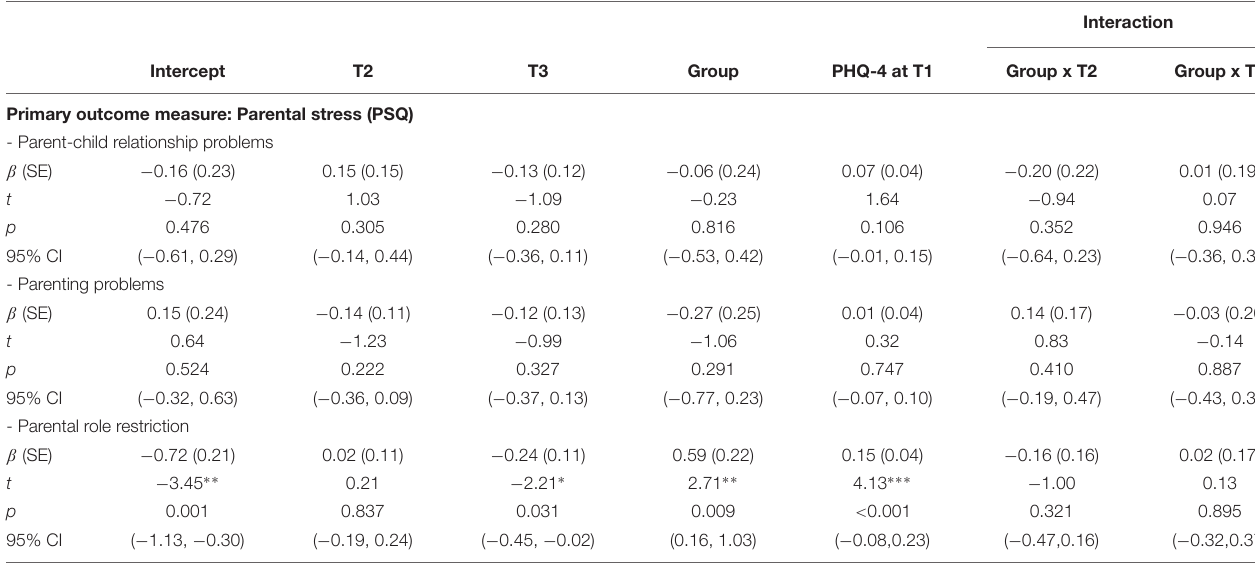
TABLE 6 | Primary outcome measure (parental stress): Standardized parameter estimates (and standard errors), t and p values, and 95% confidence intervals of multilevel models of intervention outcome predicted by measurement point (T2 and T3, deviations from T1), group [intervention (reference) and waitlist control group], control variable (PHQ-4 score at T1), and interaction variables (group by T2 and T3).